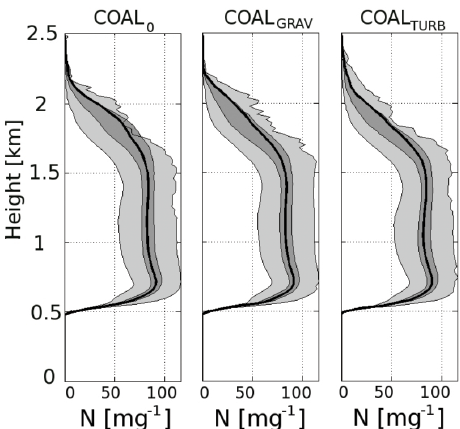
Fig. 7. Percentiles of the total drop concentration for the N 120 case. Left, middle, and right panels show results from simulations without collision-coalescence, with gravitational collision-coalescence, and with turbulence-enhanced collision-coalescence,